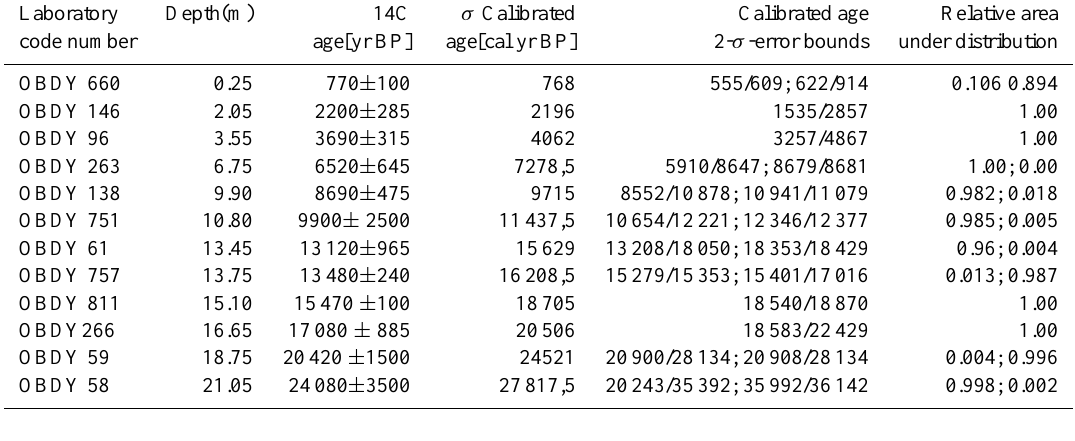
Table 1. Radiocarbon ages performed on core BM-6, Lake Barombi Mbo, western Cameroon.